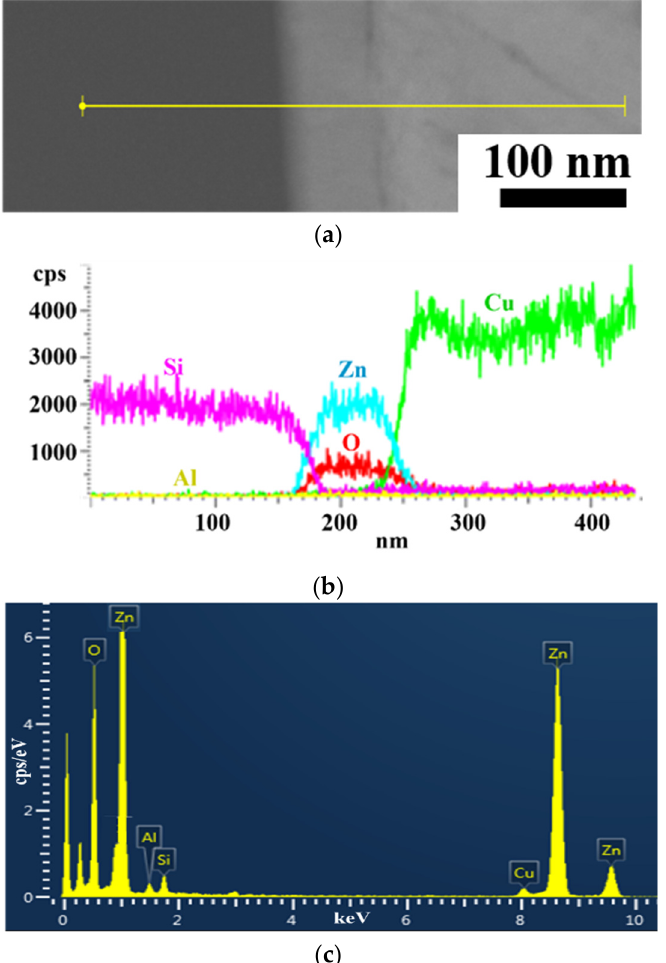
Figure 4. STEM-EDS line scan across the Cu/AZO/Si sample annealed at 300 °C. ( a ) STEM image and ( b ) intensity signal of Si, Zn, O, Al, and Cu elements along the yellow line. ( c ) EDS spectra of AZO layer.